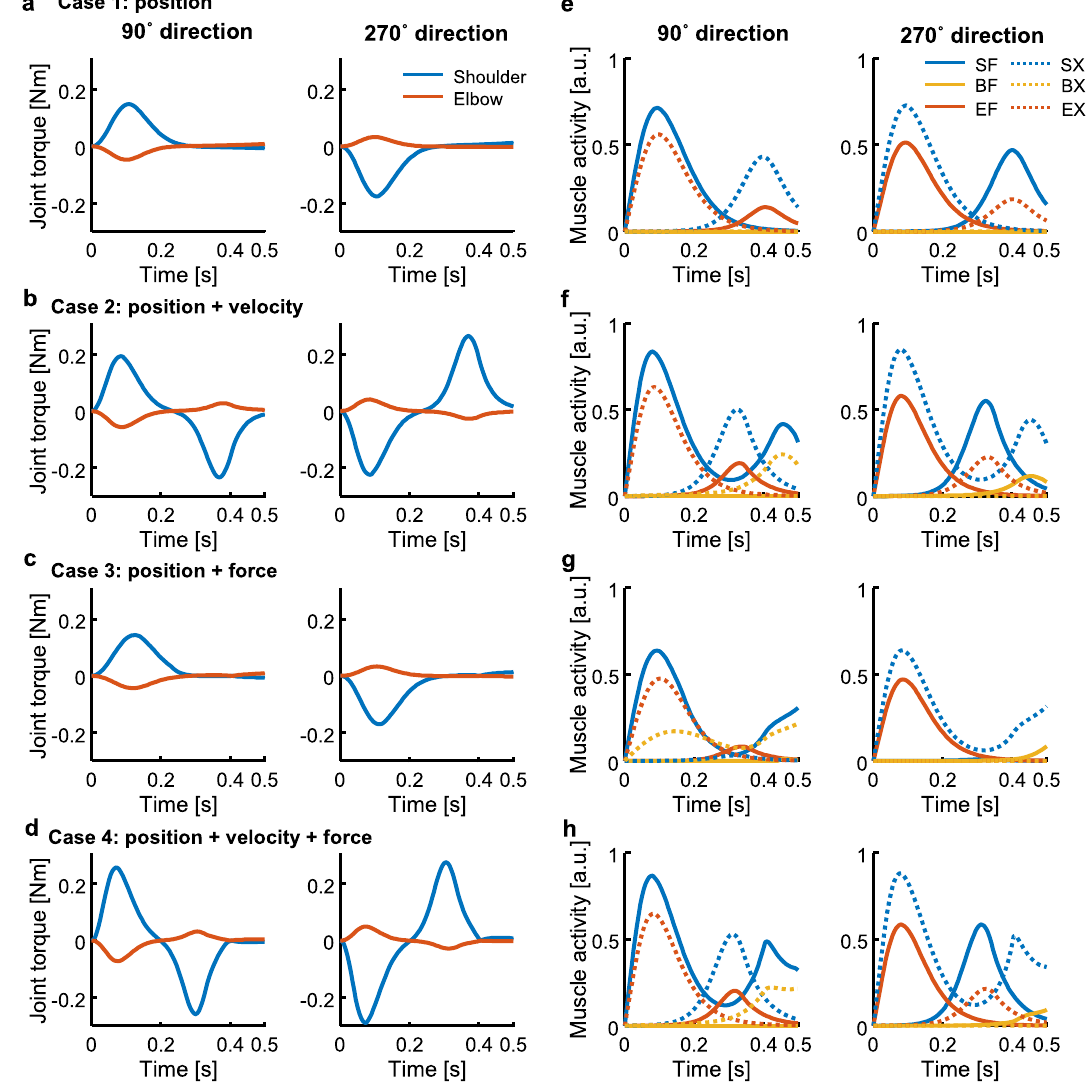
Figure 4. Example of joint torques and muscle activities for forward (90°) and backward directions (270°). Cases 1–4 are in rows from top to bottom, respectively. ( a – d ) Joint torques profiles. ( e – h ) Muscle